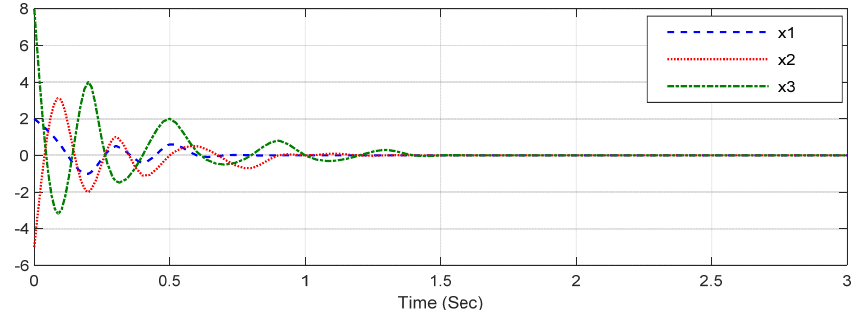
Figure 8. The control signal generated by the proposed control system is shown in Figure 9.